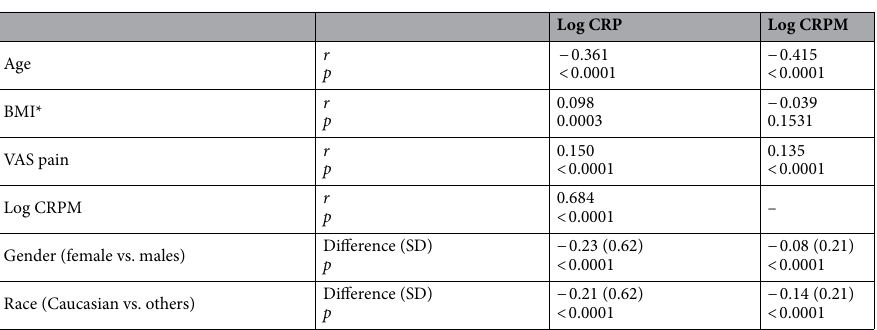
Table 2. The univariate association of log CRP and log CRPM levels with common age, BMI, gender, VAS pain, gender, race or each other, and shown as either univariate Pearson correlation coefficient r or difference (SD) in mean levels. All cohorts were included in the analysis, except for BMI which was only available in the MS-RA and the OA cohort (*).